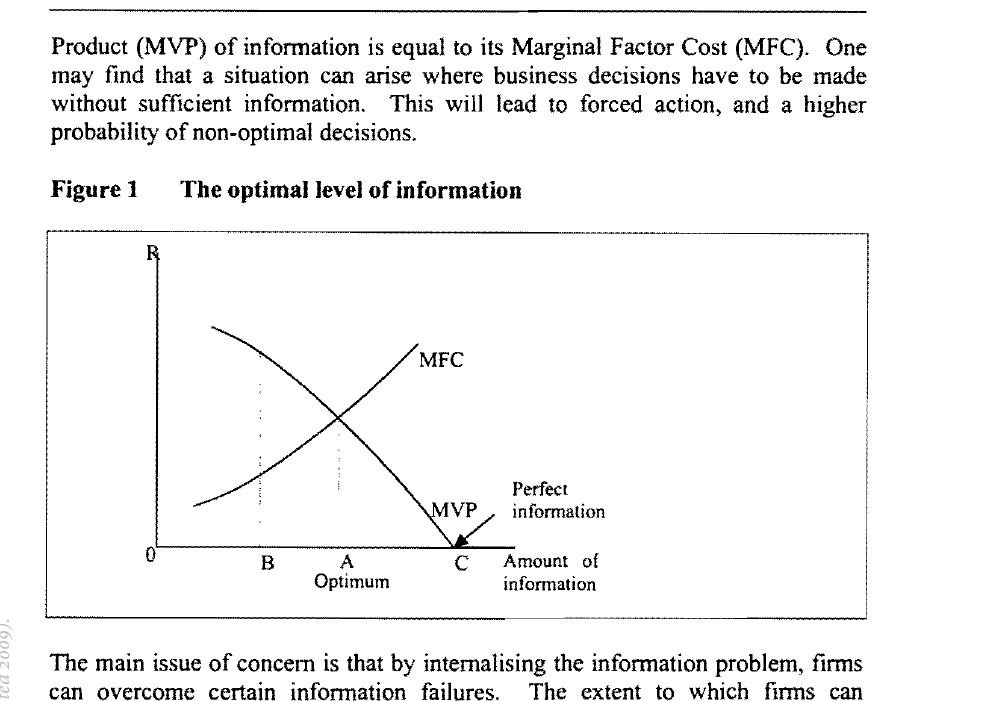
The optimal level of